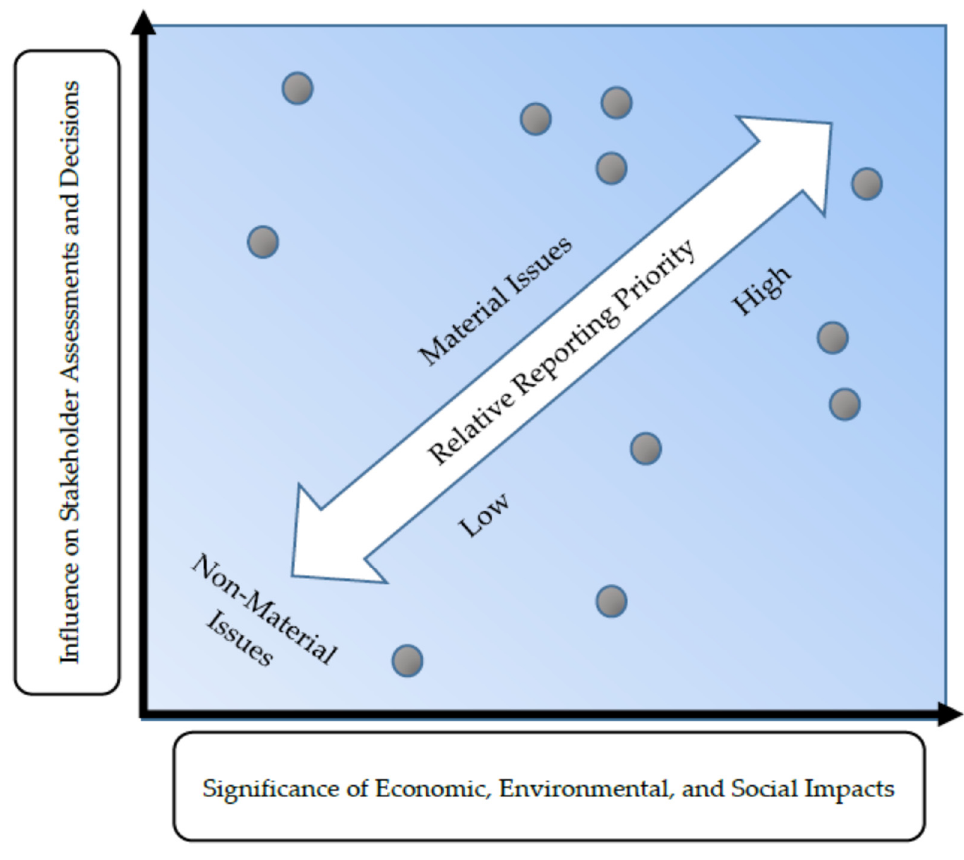
Figure 1. Examples of first materiality matrices in standard setters’ documents: a rielaboration of axes labels and graphical formats in 2006 GRI Guidelines.